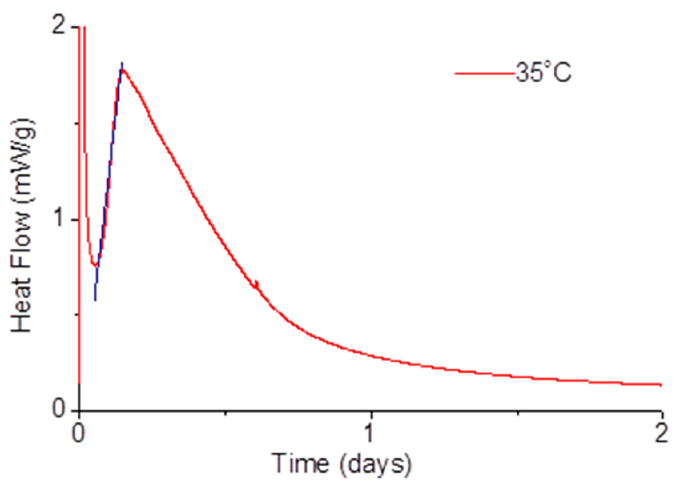
Figure 2. Heat release of a paste activated with Na 2 SiO 3 and a water/solid ratio of 0.35 at 35 °C, with a best-fit line on the linear acceleration period (blue line). Figure 3 correlates ln(k) with 1/T for each temperature and hydration condition. The fit for alkali-activated pastes at different temperatures is depicted as a red dashed line, while the fit for pastes prepared with water is shown as a blue dashed line. The activation energy values were determined by using the expressions 3 and 4, which represent the fitting equations obtained from Figure 3, and the values of 82 kJ/mol and 85 kJ/mol were obtained for the alkali-activated pastes and for the pastes prepared with water, respectively.